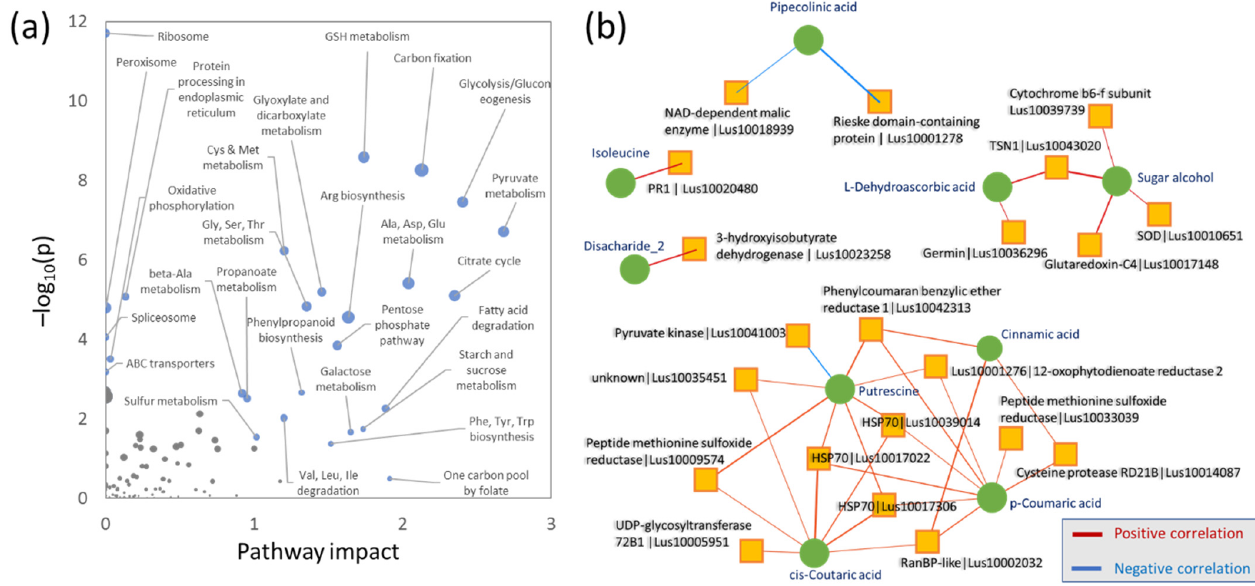
Figure 7. Integrative analysis of proteomics and metabolomics data. ( a ) Visualization of metabolic pathways significantly impacted by cadmium treatment and ( b ) significant intra-omics correlations.